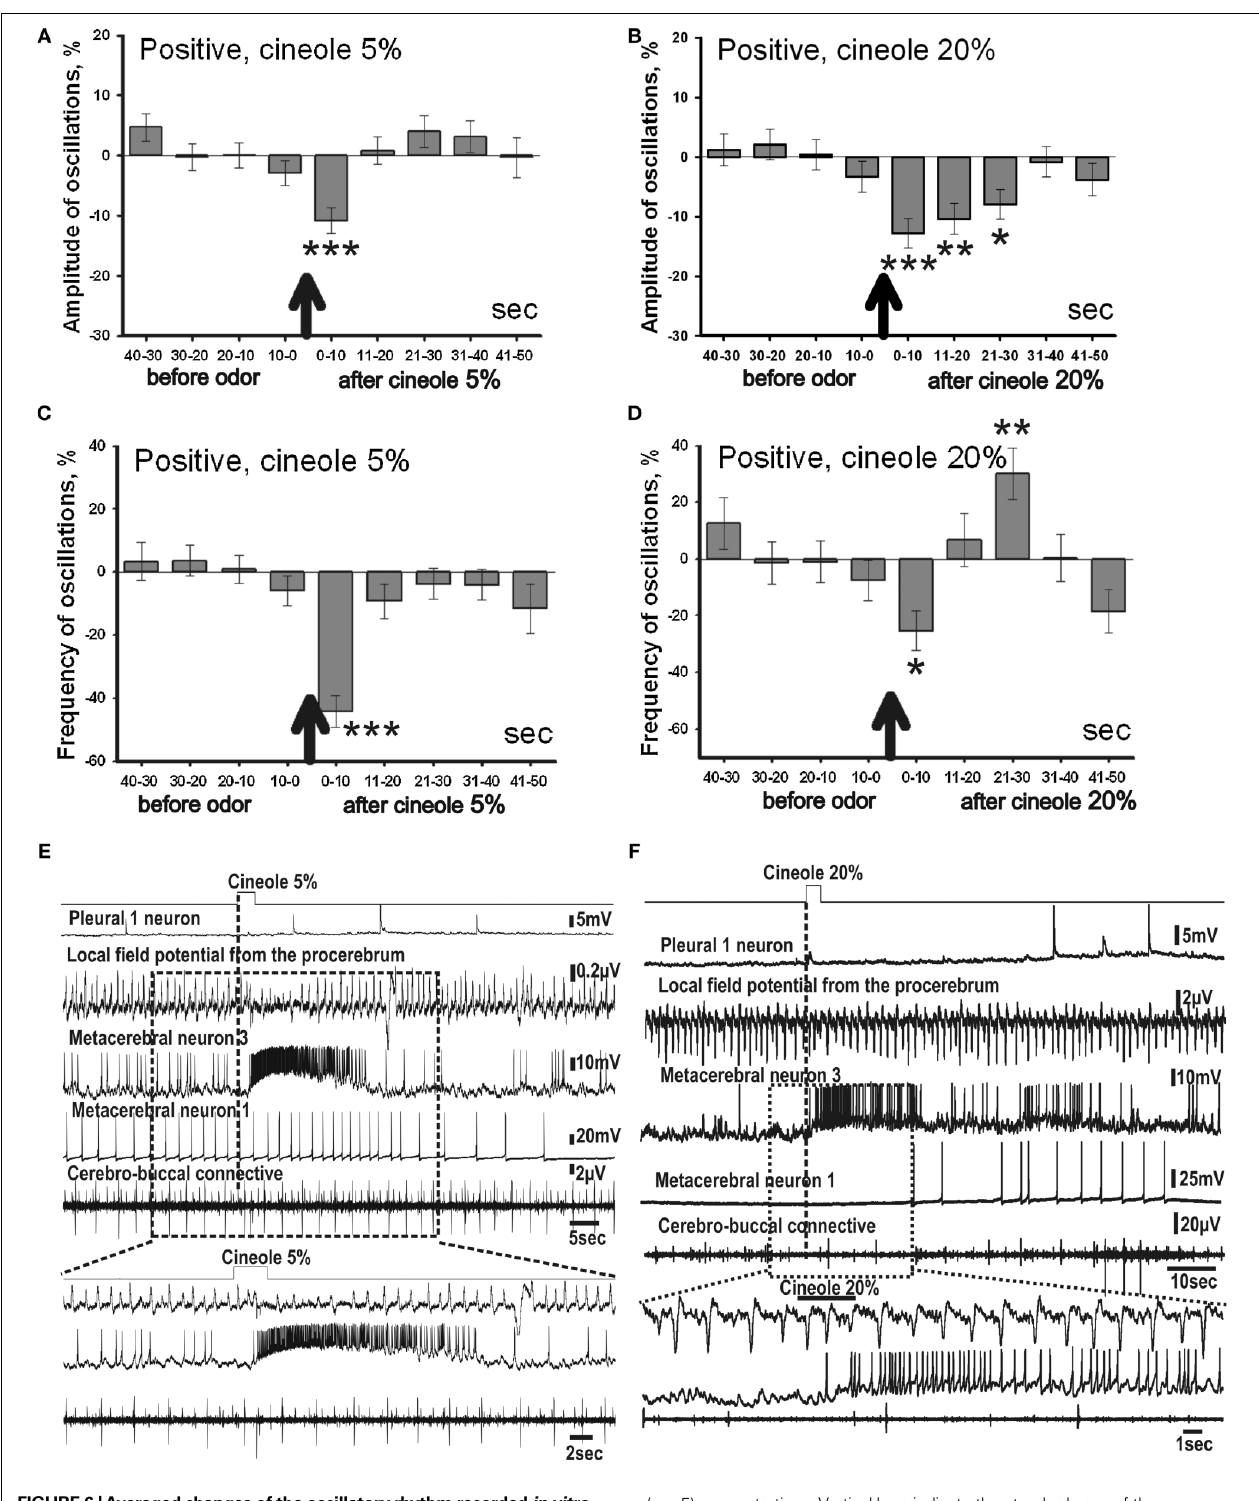
( n = 5) concentrations. Vertical bars indicate the standard error of the mean. * p < 0.05, ** p < 0.01, *** p < 0.001. (E,F) The response of the procerebrum, MtC3, MtC1 neurons and the cerebro-buccal connective to cineole 5% (E) and 20% (F) application to the nose–brain preparation of the snail trained to respond with the feeding reaction to the